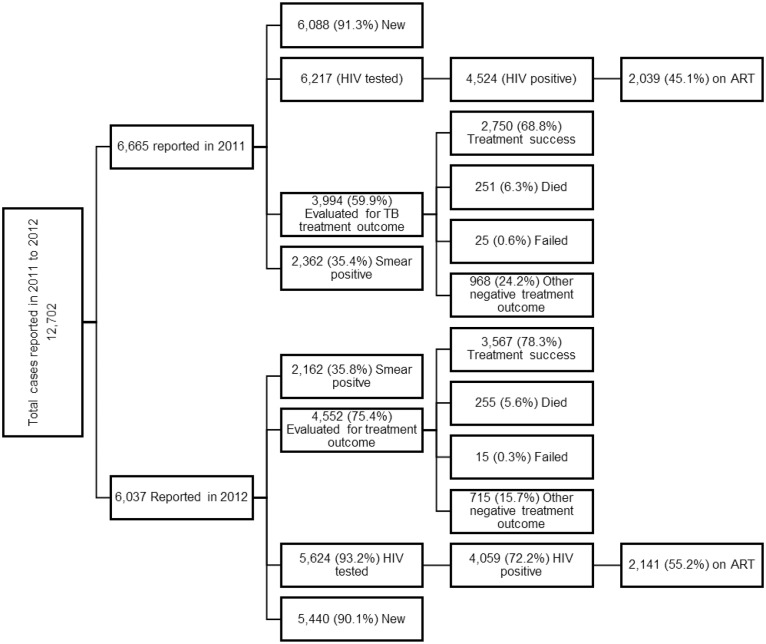
Characteristics of tuberculosis patients receiving treatment in Harare City, 2011–2012.The figure summarises the total TB cases included in the study disaggregated by year of treatment, TB patient type, HIV testing and antiretroviral therapy (ART) status and treatment outcome for 2011 and 2012, Harare City.